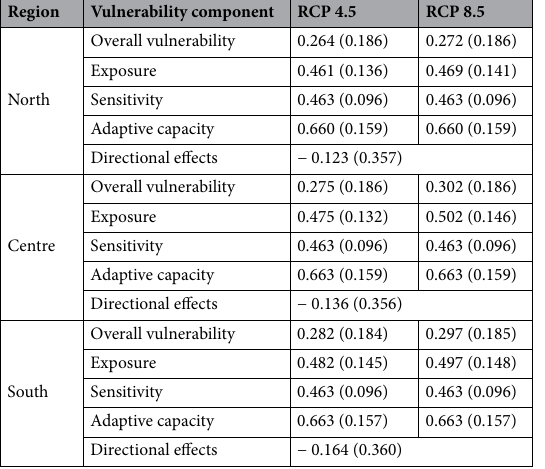
Table 3. Average and standard deviation values of overall vulnerability, exposure, sensitivity and adaptive capacity (in a scale of 0–1) and directional effects (in a scale of − 1 to 1) for each region and scenario of climate change based on the 74 species under consideration.